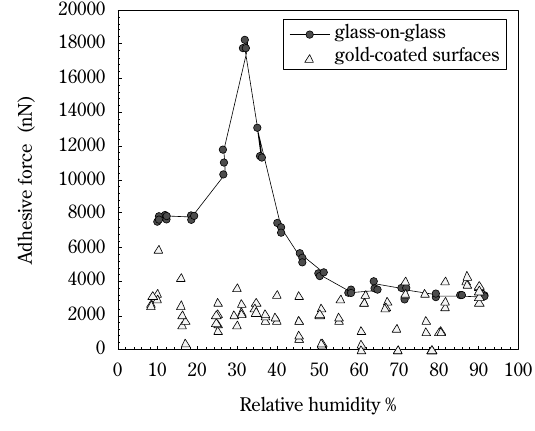
Fig. 4 Adhesion as a function of relative humidity for sphere (diameter 37 µ m) interacting with a flat surface. The glass interactions are shown for decreasing humidity. The same peak in adhesion was not observed during increasing humidity. The data for gold-coated glass were obtained whilst increasing and decreasing humidity.